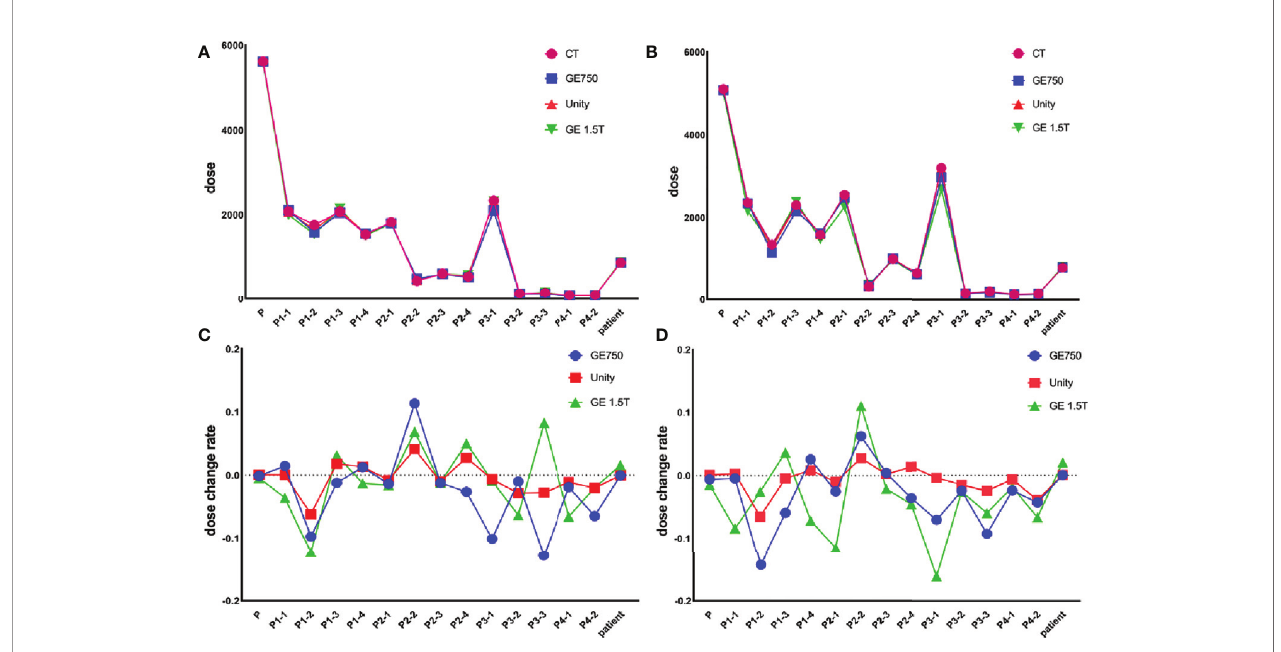
FIGURE 7 | Actual dose without the magnetic fi eld (A) and in the magnetic fi eld (B) . The dose change rate without the magnetic fi eld (C) and in the magnetic fi eld (D) .